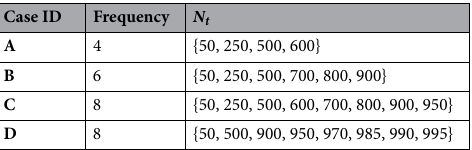
Table 4. Case studies: autonomous guidance